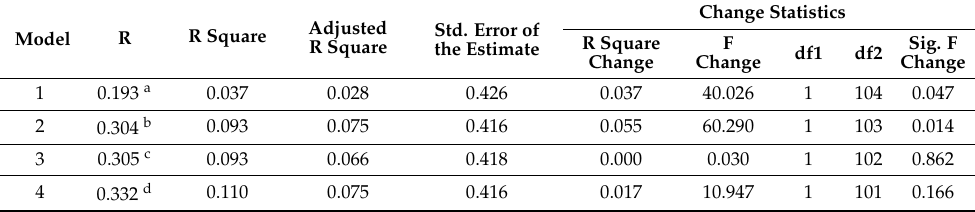
Table 2. Multivariate analysis. Impact of demographical data on pneumonia.